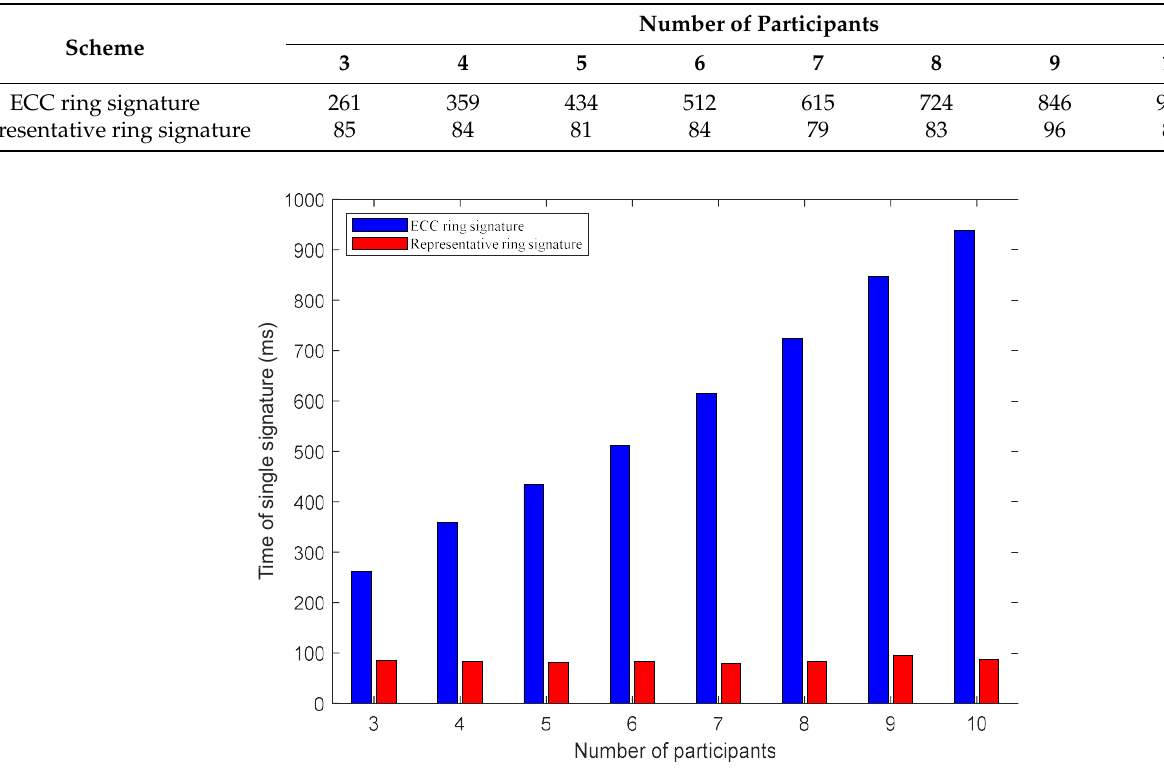
Table 3. Comparison of signature time of two schemes (unit: ms).